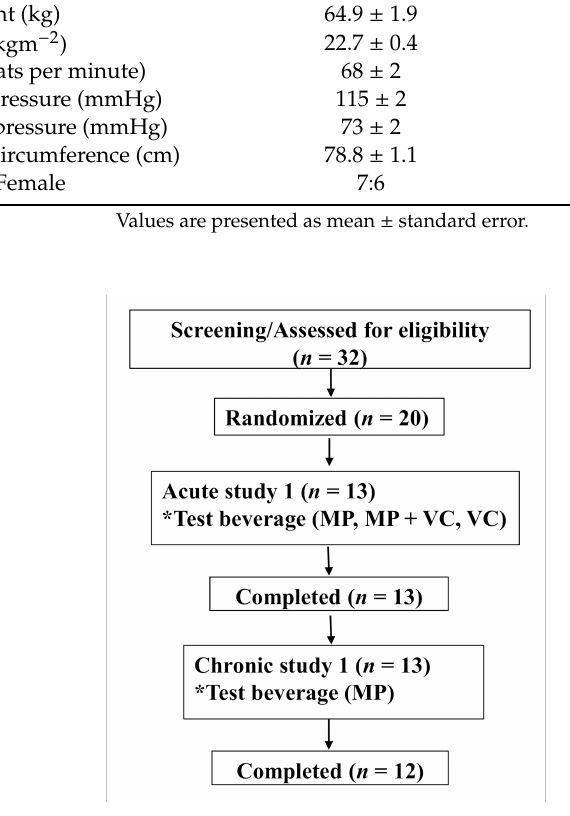
Figure 4. Consolidated Standards of Reporting Trials (CONSORT) flow diagram. * Test beverage: MP (Mango pulp (500 g)), MP + VC (Mango pulp (500 g) + Vitamin C (100 mg)) and VC (Vitamin C (100